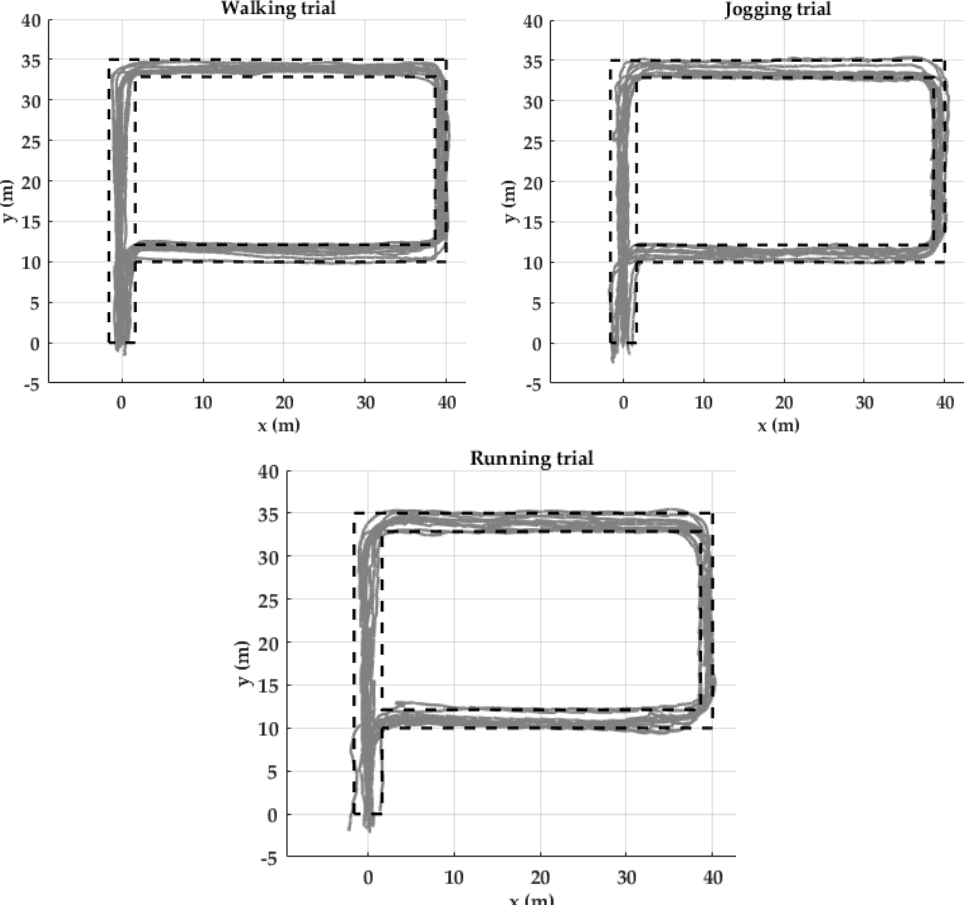
Figure 11. Trajectory reconstruction for the ten participants of the Unicauca dataset in a P shaped path. Black dotted lines show outer edges (walls) of the possible path. Gray lines are the trajectories reconstructed of the ten participants by using the proposed pipeline.